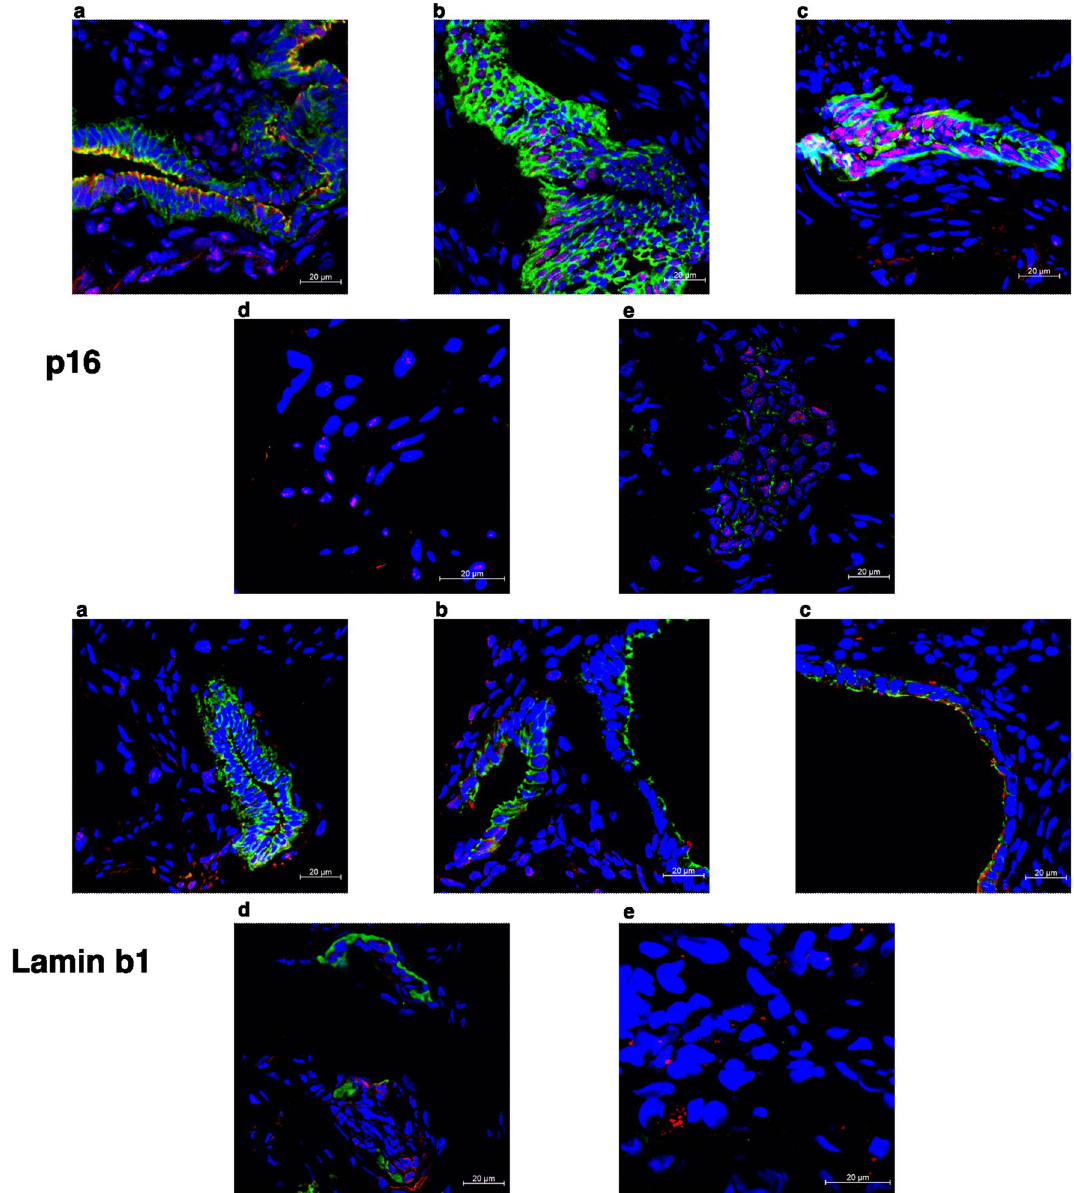
Figure 7. Representative images of endometriosis and non-endometriosis tissues costained with p16 Ink4a or lamin b1 and E-cadherin (epithelial cell marker). p16 Ink4a and lamin b1 are shown in red, E-cadherin is shown in green, and the cell nuclei is shown in blue (DAPI). ( a ) Control endometrium, ( b ) eutopic endometrium, ( c ) deep endometriosis lesion, ( d ) superficial endometriosis lesion, ( e ) endometrioma. Pictures were acquired at ×63 or ×100 oil